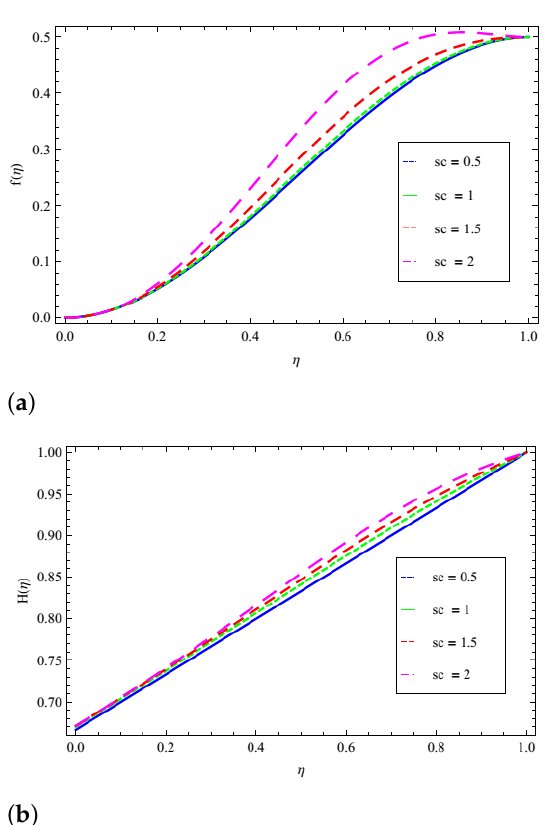
Figure 10. Impact of Sc on ( a ) velocity component f ( η ) and ( b ) homogeneous reaction H ( η ) for specific values S = − 0.5, R = 0.1, P r = K 1 = K 2 = 0.5, = Ha = 0.1, L = 2, δ = 5, Q =